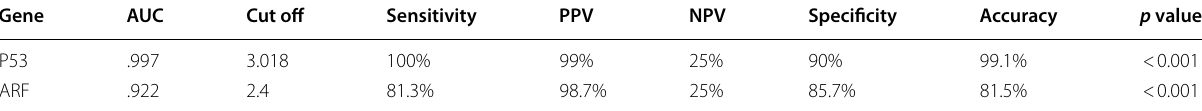
Table 2 ROC Curve analysis of P53 and ARF genes expression for diagnosis of AML patients